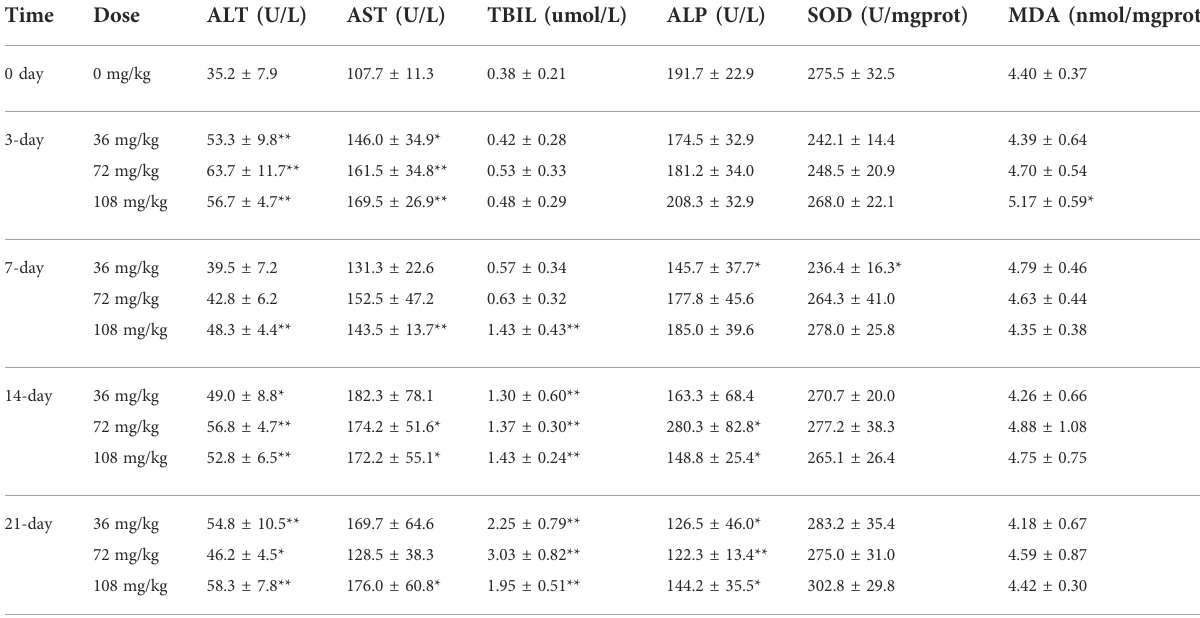
TABLE 1 Levels of biochemical indicators in